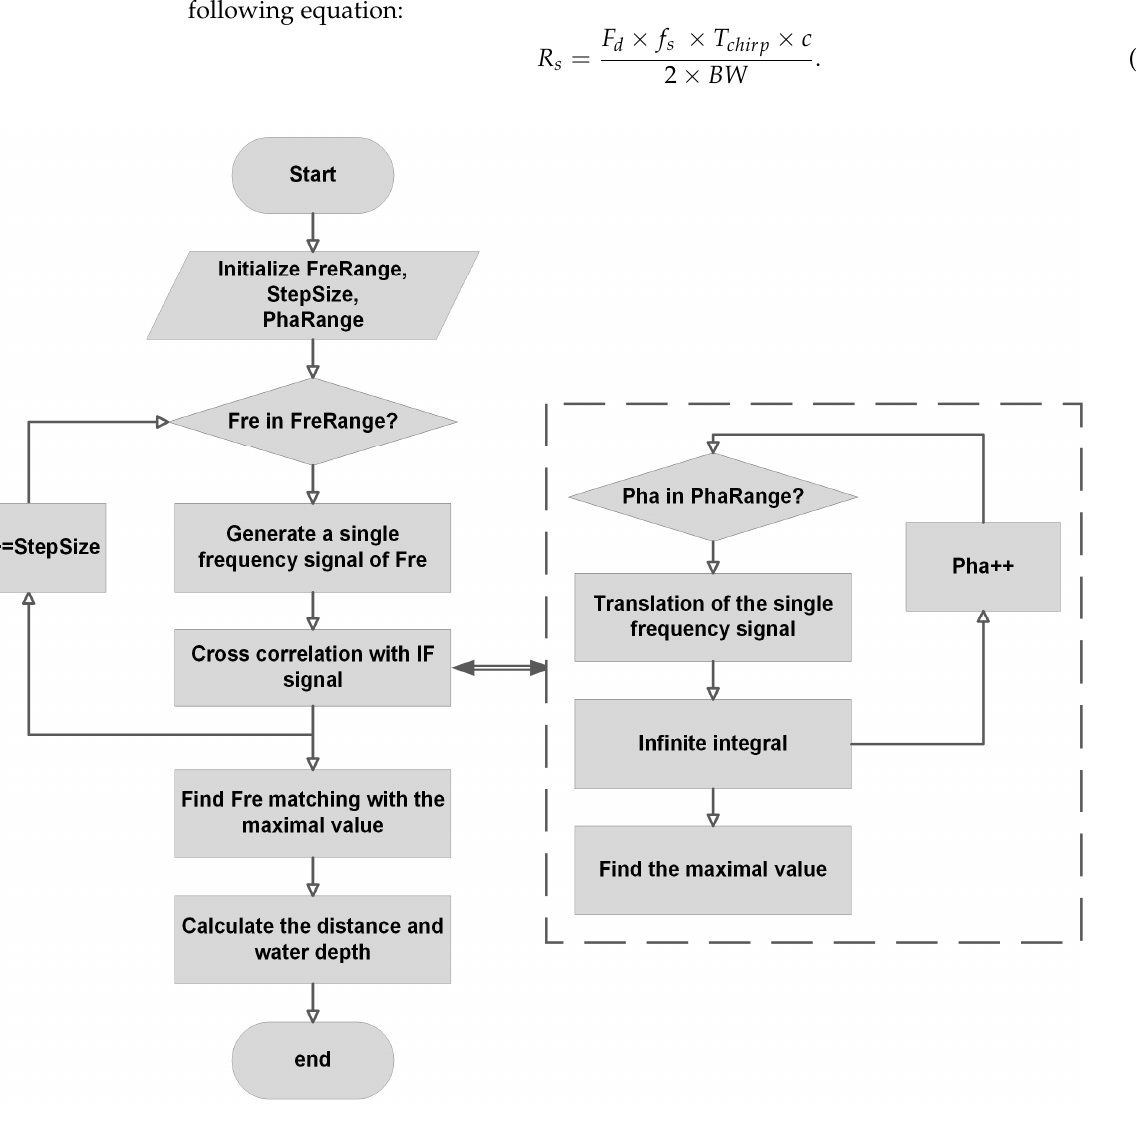
Figure 3. SFCC flow chart.